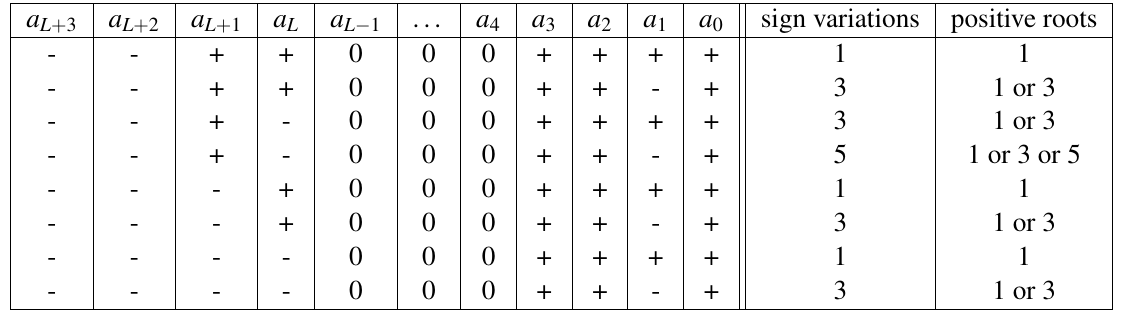
Table 3 Signs of the coefficients of equation (7) for a general value of